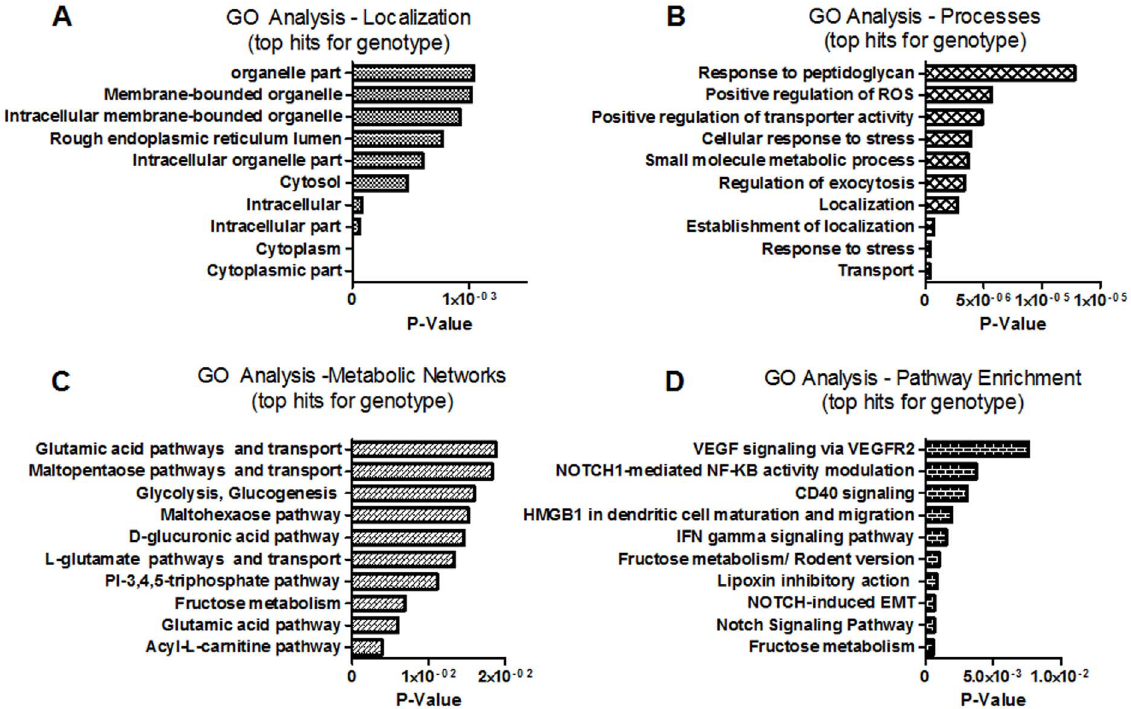
Figure 4. GO Enrichment Analysis for top hits of genotype significant Genes: GO Term analysis were performed using GeneGo on the list of significant genes varying by genotype, FDR , 0.05. Top 10 hits (where applicable) is presented for (A) Localization, (B) Cellular Processes, (C) Metabolic Networks, and (D) Pathway Enrichment. P values for GO analysis are calculated based on hypergeometric distribution. The P- values on the graph indicate the probability of mapping of an experiment to a process to arise by chance.